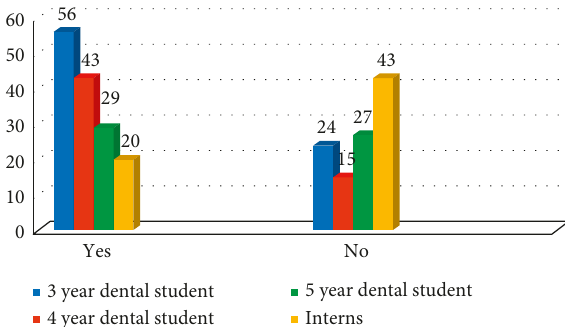
Figure 4: Knowledge of participants toward the benefits of using collimators and filters in dental radiography ( χ 2